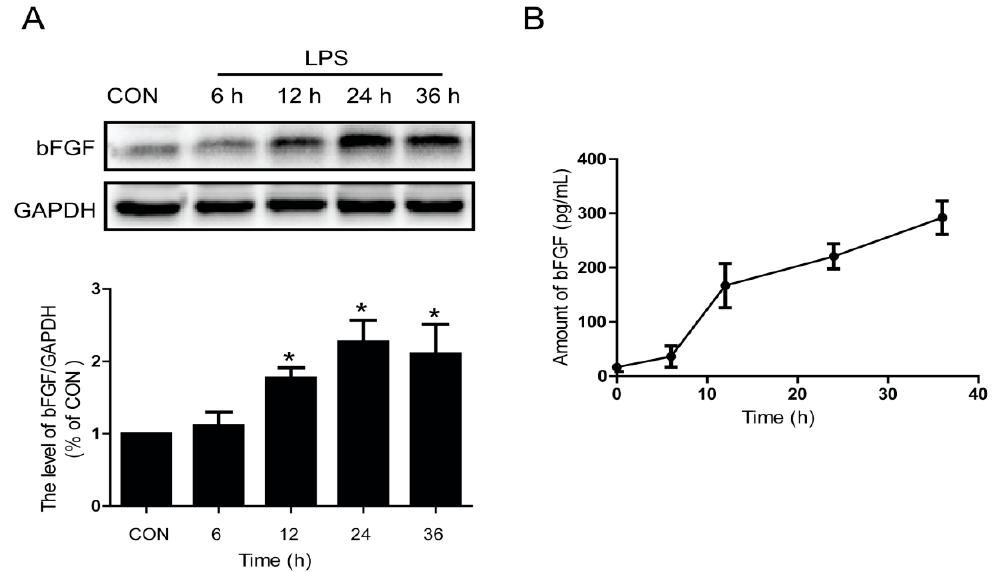
Figure 1. Activation of astrocytes enhanced bFGF Release. LPS (2 µg/mL) was used to stimulate astrocytes for different times. ( A ) Western blot of bFGF and densitometric analyses; ( B ) ELISA of bFGF. * p < 0.05 versus control (CON). All results represent at least three independent experiments.